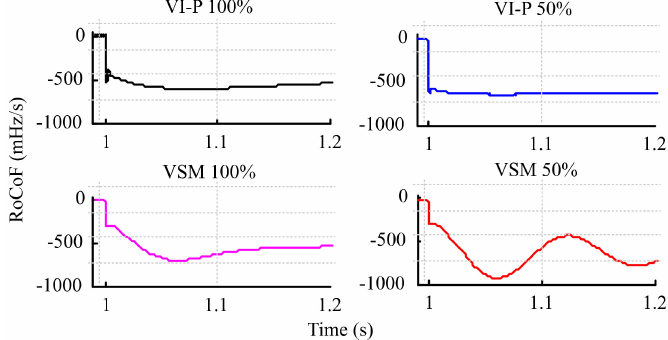
Figure 17. Zoom of the RoCoF ∆ t variation on the load change if the BESS assumed 100% of the load variation versus